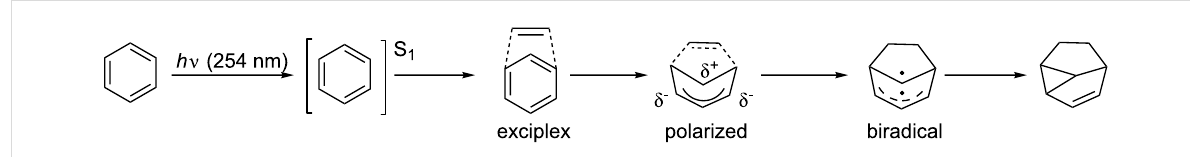
Scheme 5: Mechanism of the meta photocycloaddition.